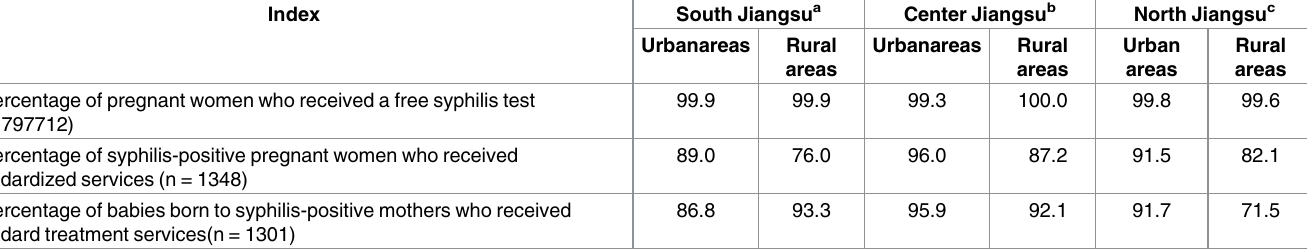
Table 3. Test and treatment among pregnant women and babies born to syphilis-positive mothers in urban area and rural area in Jiangsu, China 2015. Index South Jiangsu a Center Jiangsu b North Jiangsu c